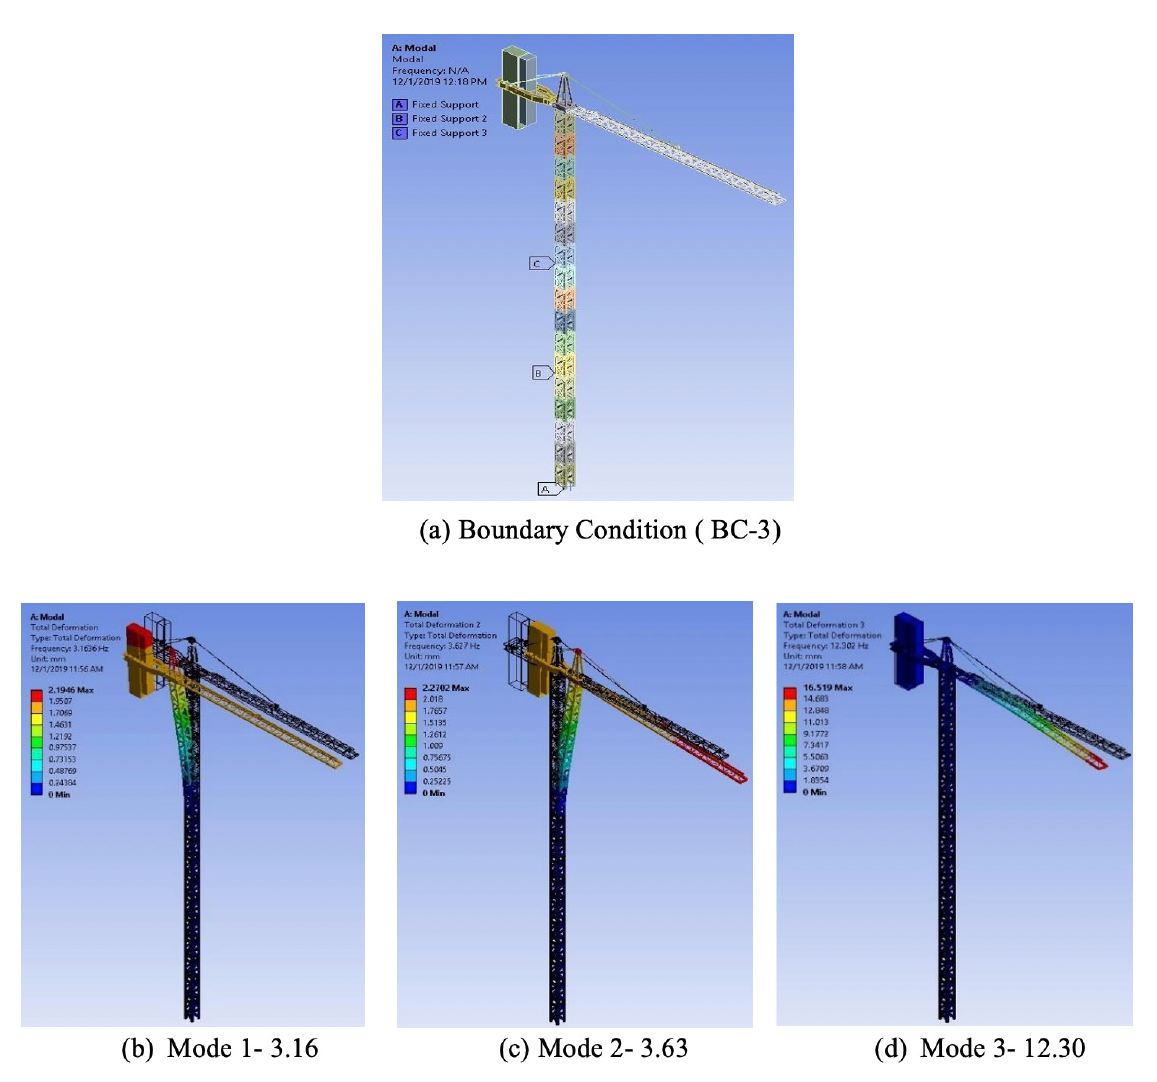
Figure 11. Modal Parameters of tower crane with 2 bracings may be successfully implemented in the tower crane for en- hancing its overall